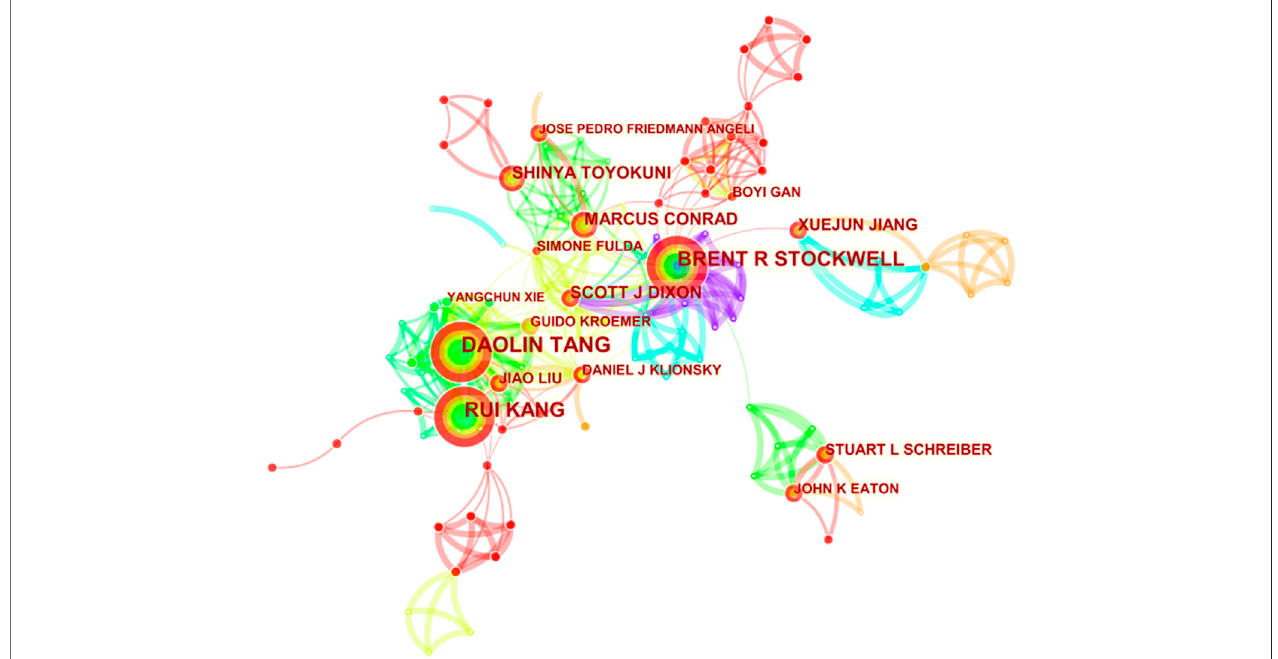
FIGURE 3 | CiteSpace network visualization map of co-cited authors of the articles related to ferroptosis in cancer research.